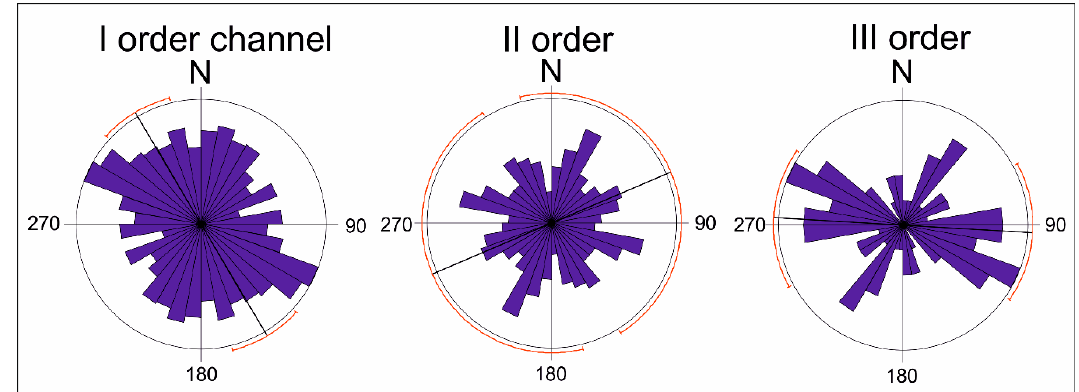
Figure 6. Frequency-weighted rose diagram of the I, II and III order channels of the study area. Black lines are the mean vector of the statistical population whereas the red arc circles indicate the 95% confidence interval of the azimuthal